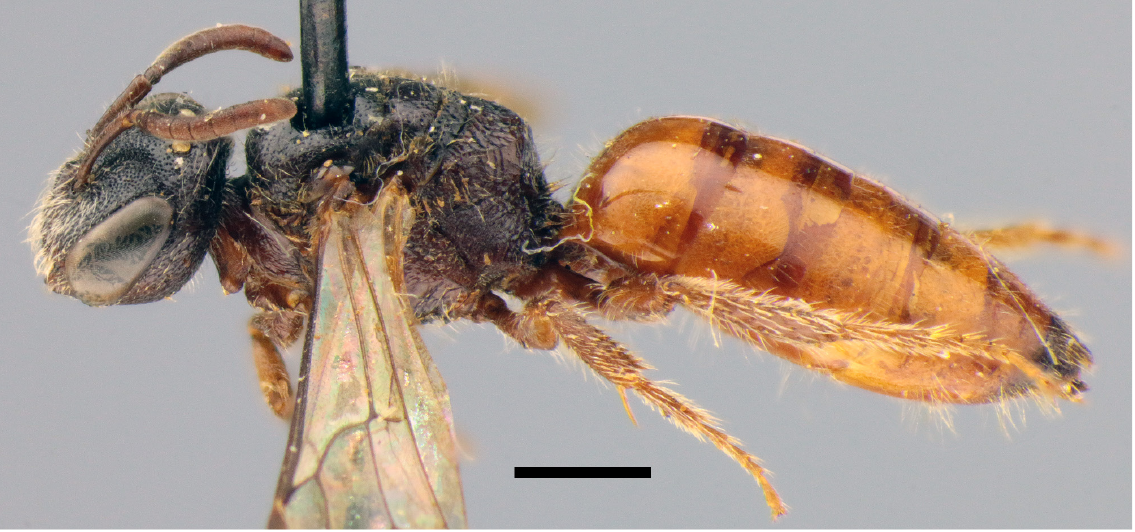
Fig. 19. Sphecodes tantalus Nurse, 1903. Syntype, ♀ (ZMHB). Habitus in lateral view. Scale bar = 1